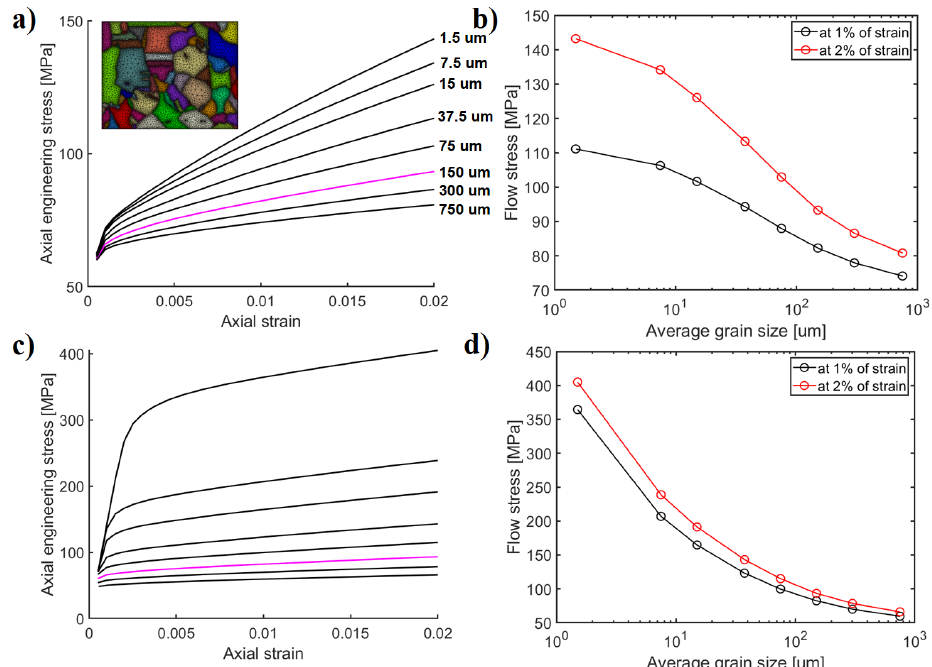
Figure 2. ( a ) Stress–strain curves for different grain sizes without Hall-Petch offset, ( b ) flow stress values at constant strains for different grain sizes, ( c ) stress–strain curves for different grain sizes with Hall-Petch offset, and ( d ) flow stress values at constant strains for different grain sizes using Hall-Petch offset. The computational RVE shown in ( a ) is used for all cases; it is scaled to achieve the specific grain